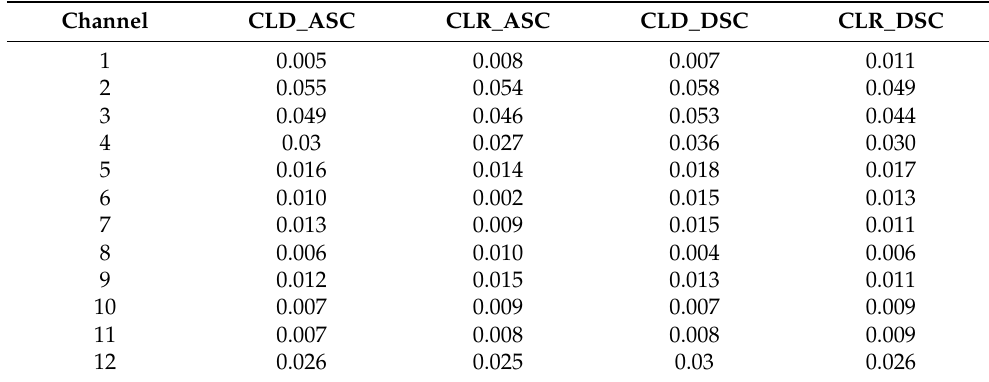
Table 2. Mean standard deviation (mean of January, April, July, and October) of dBT after calibration for all categories in Figure 8. Units are in